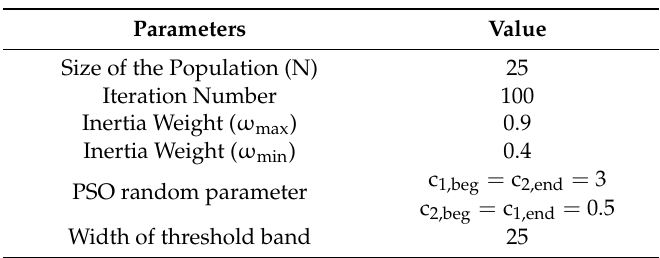
Table 1. Parameters for DPSO.